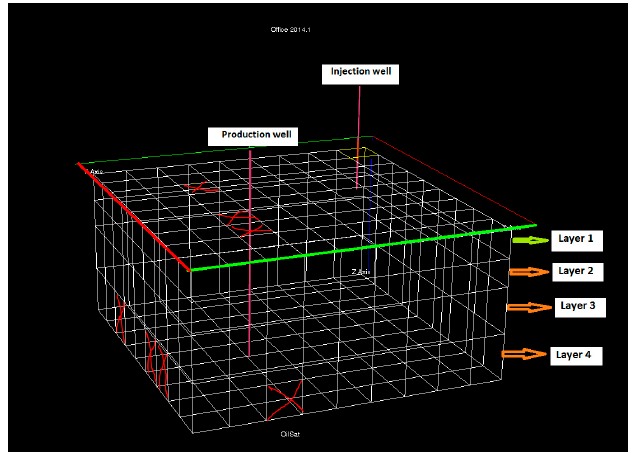
Figure 2. A 3D Image of selected blocks of interest; from top to the two sides.